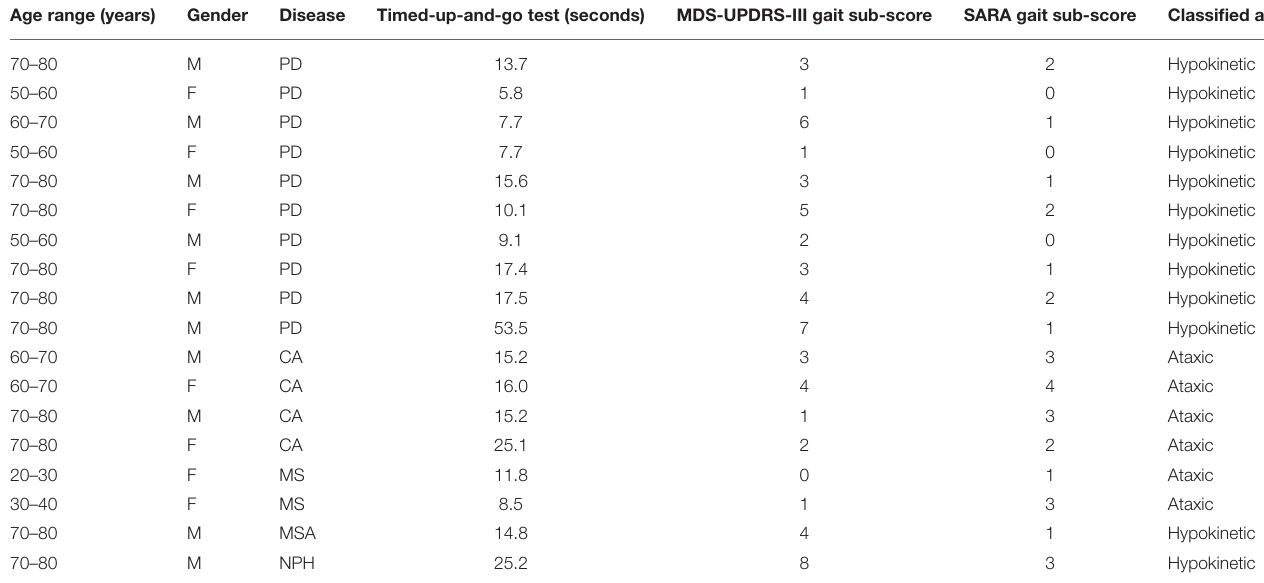
TABLE 1 | Patient